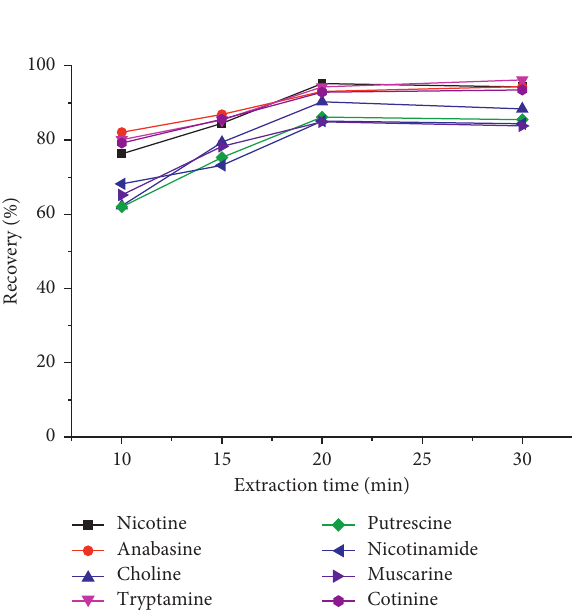
Figure 2: Comparison of extraction efficiency at extraction